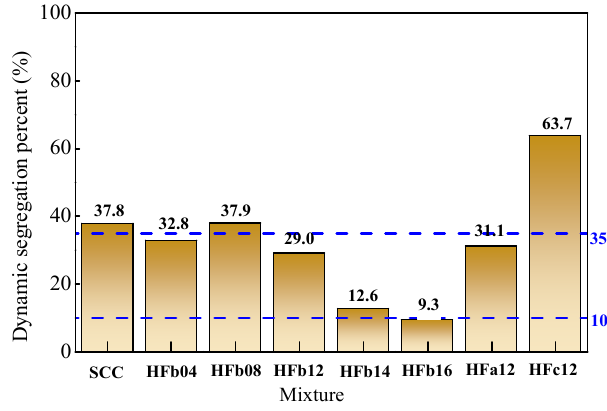
Figure 9. Dynamic segregation percent and resistance level of coarse aggregate.